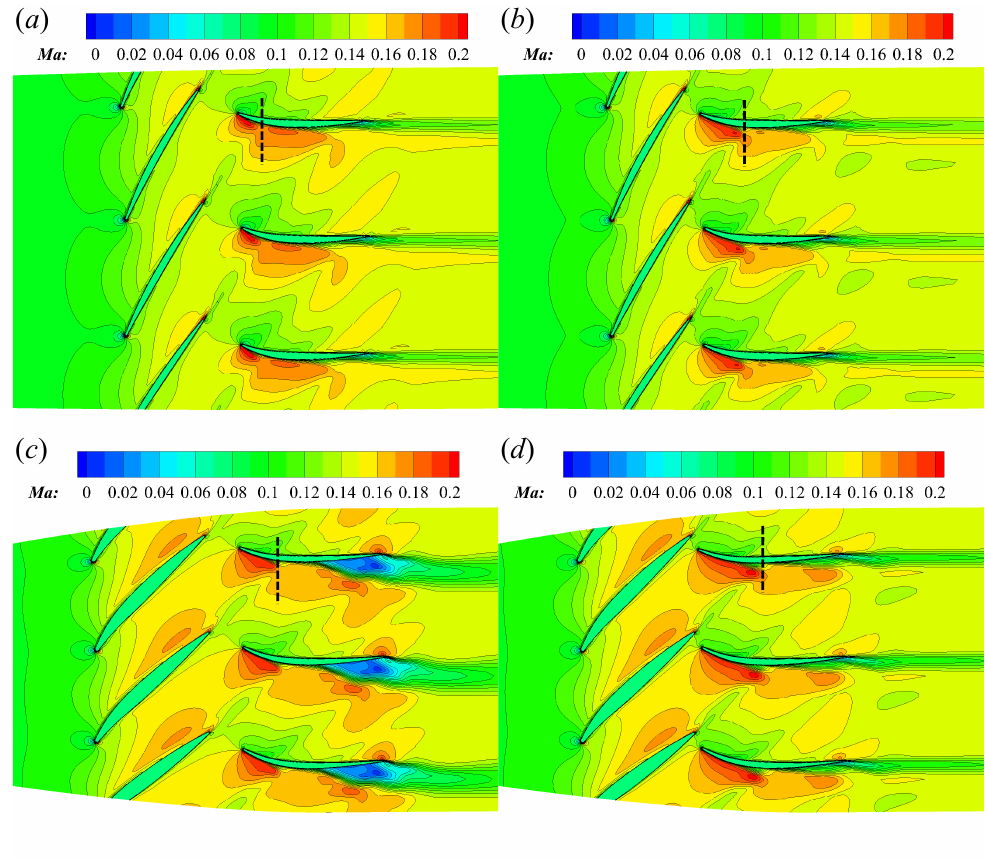
Figure 16. Flow contours of Ma on two span sections at φ = 0.318 for the two gaps: ( a ) 90% span and g = d 0 ; ( b ) 90% span and g = 0.1 d 0 ; ( c ) 20% span and g = d 0 ; ( d ) 20% span and g = 0.1 d 0